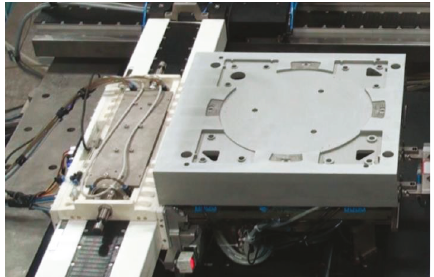
Figure 7: Long-stroke wafer stage motion